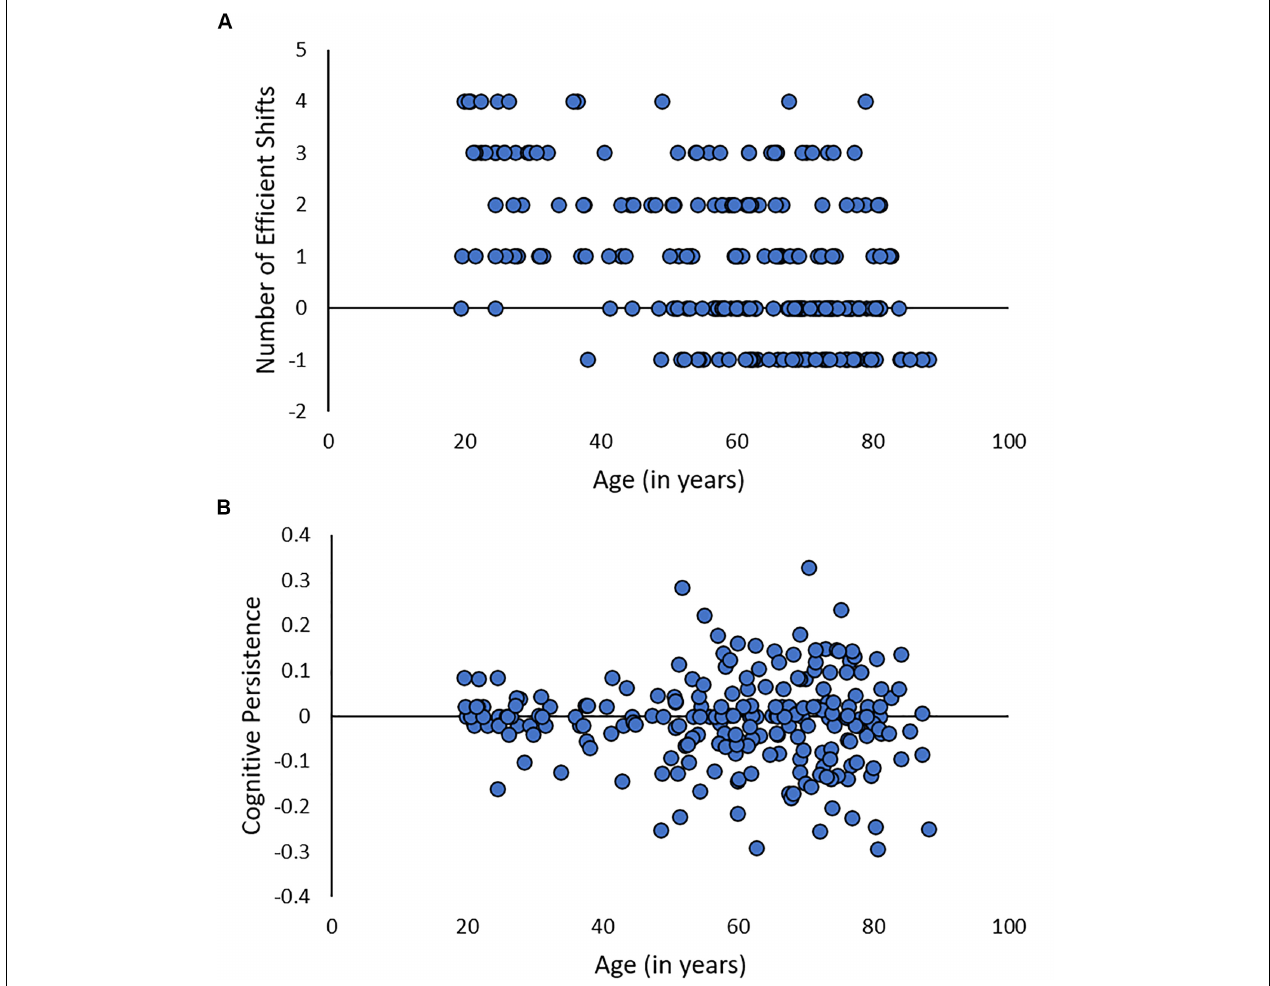
FIGURE 2 | Unpublished data from Teubner-Rhodes et al. (2017) showing the relationship between age and number of efficient shifts (A) or cognitive persistence (B) on the